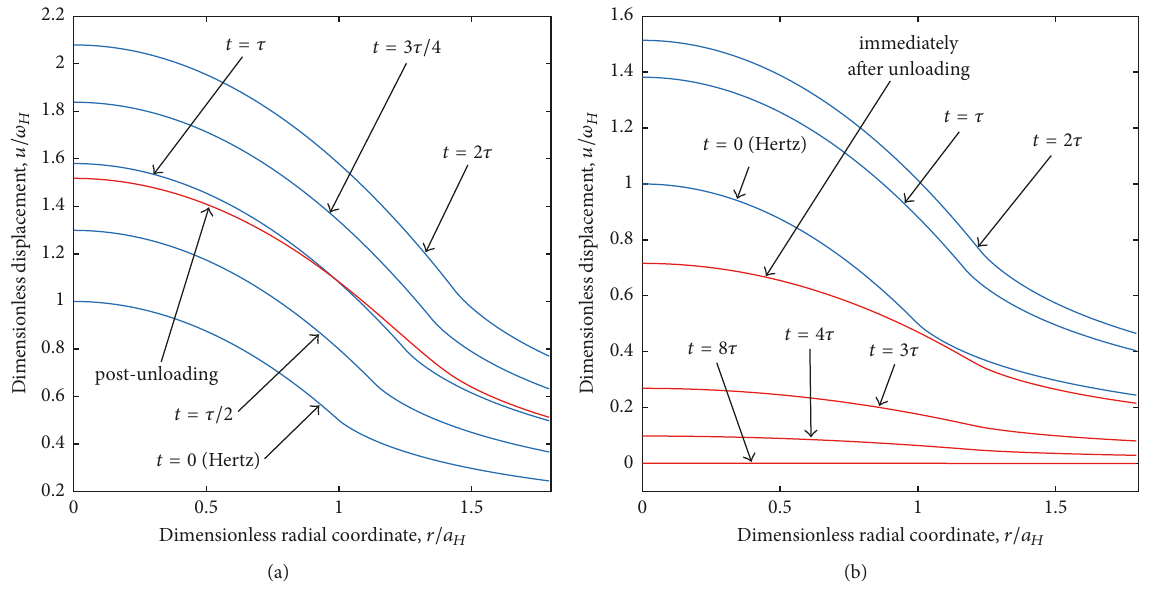
Figure 7: Surface displacement in a loading program consisting in a step loading at 𝑡 = 0 followed by instantaneous unloading at 𝑡 = 2𝜏 ; (a) Maxwell half-space and (b) Zener